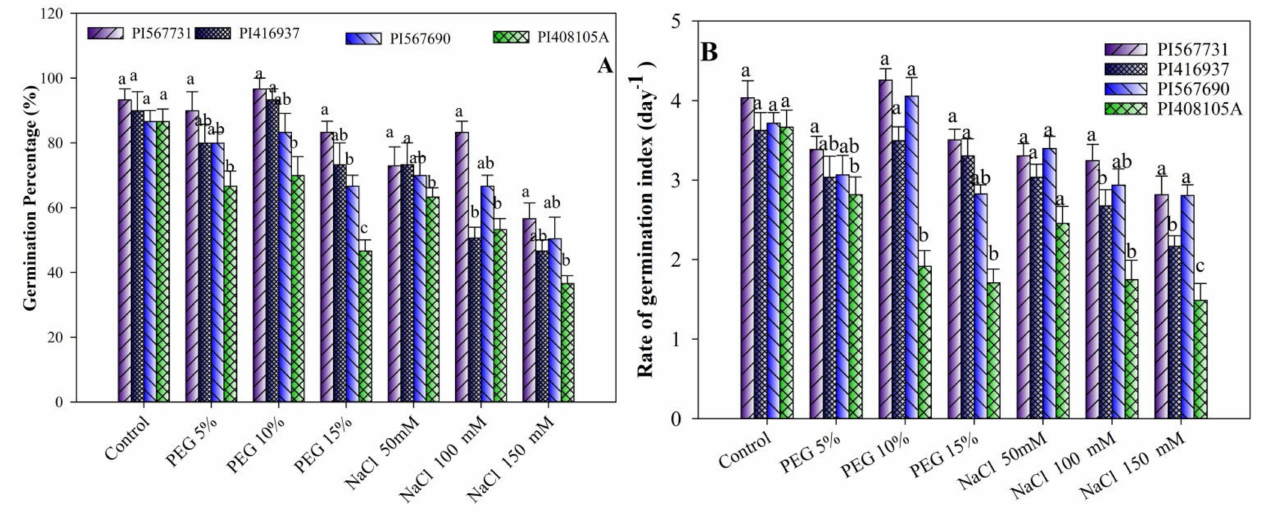
Figure 1. ( A ) Seed germination percentages (SGP) and ( B ) rate of germination indexes (GRI) of four soybean cultivars grown under drought and salinity stress conditions. Data presented are means ± SD. Different letters denote a significant difference at p < 0.05 based on the least significant difference (LSD) test. Letter a is highly significant than b, and ab means no significant differences between a with ab and b with